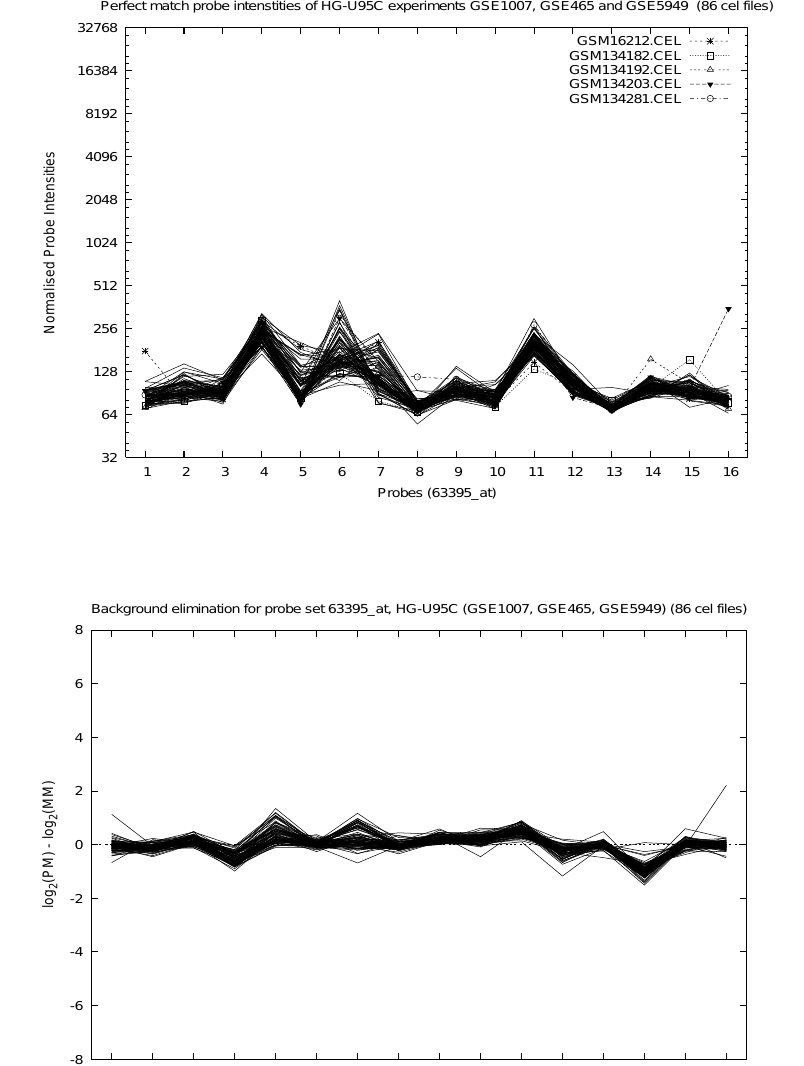
Figure 4: Probe intensities for experiments GSE1007, GSE465, GSE5949 of probe set 63395 at on the HG U95C array (A) Perfect match intensities (log scale) (B) Background elimination (log 2 (PM) - log 2